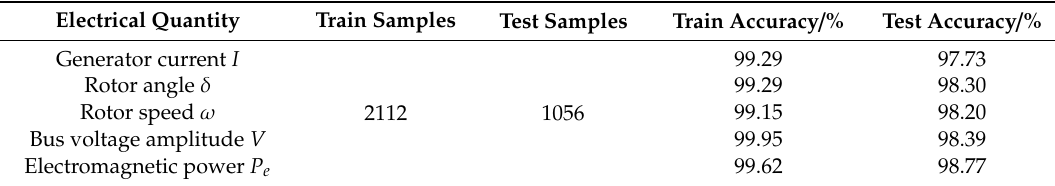
Table 1. Prediction performance of di ff erent types of input features.